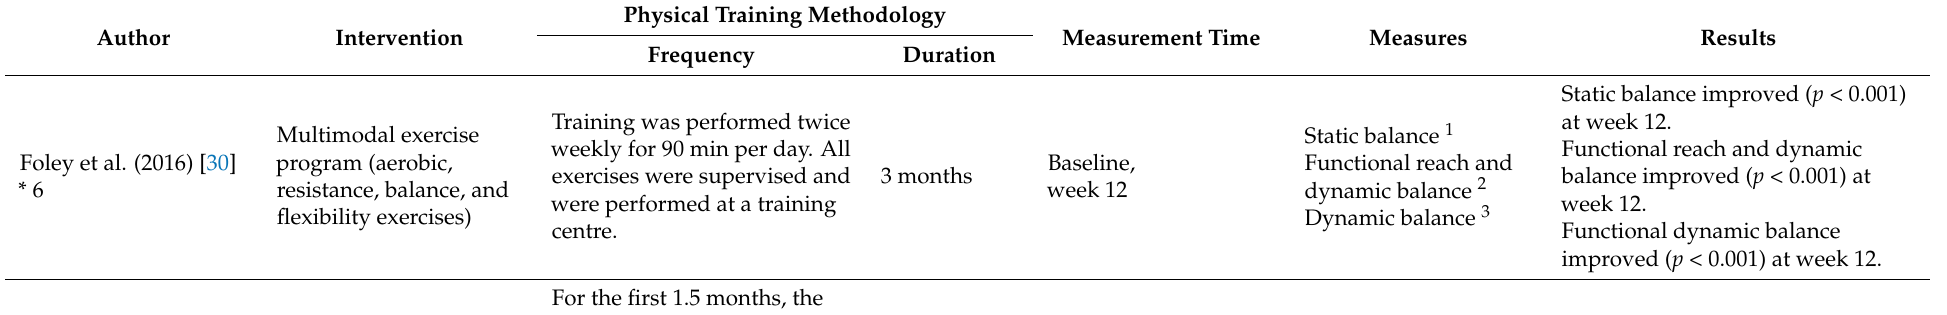
Table 8. Methods of pilot clinical trials and their results regarding the static and dynamic balance of the